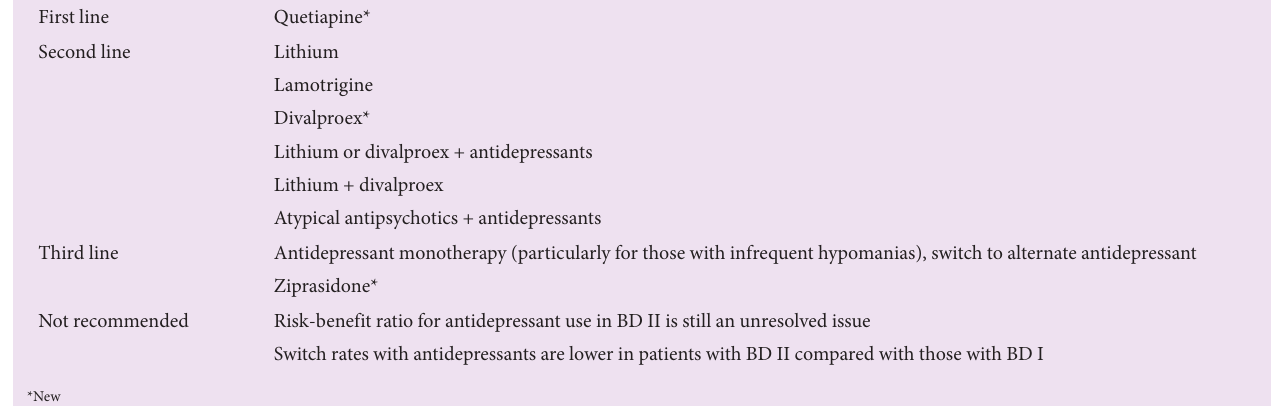
Table 2. Recommendations for pharmacological treatment of acute bipolar II depression